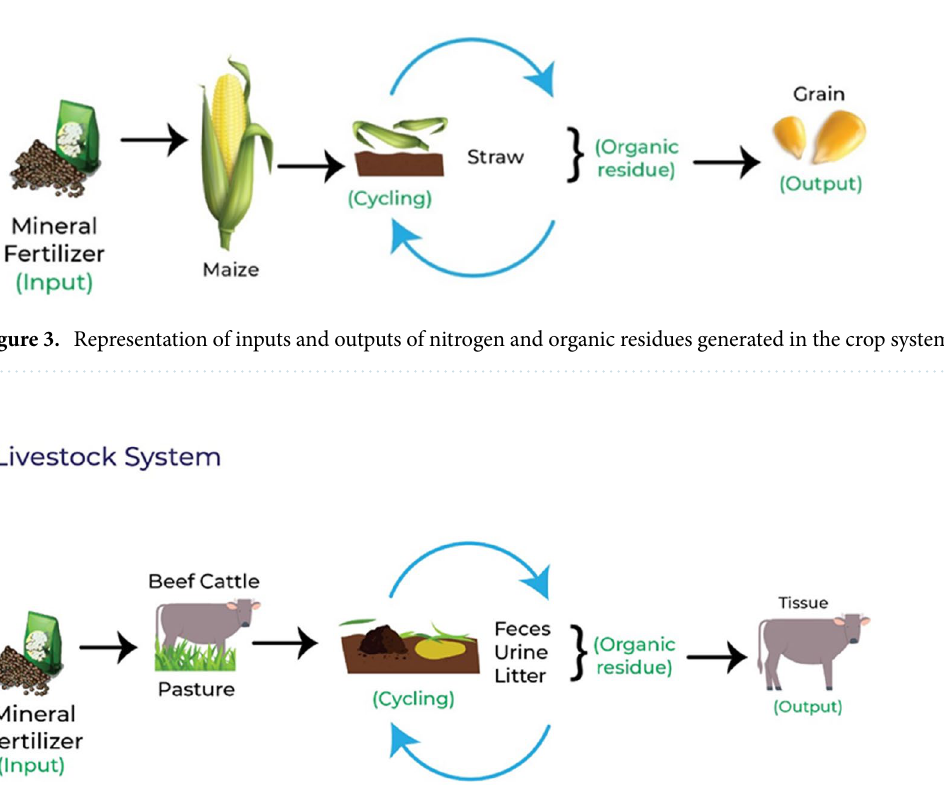
Figure 4. Representation of inputs and outputs of nitrogen and organic residues generated in the livestock system.